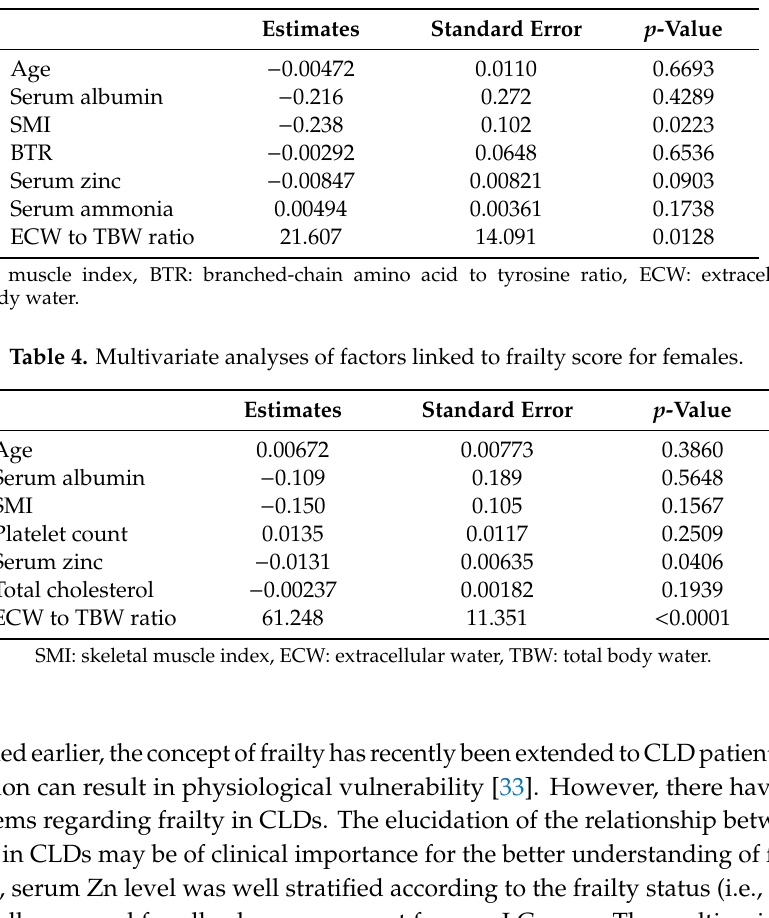
Table 3. Multivariate analyses of factors linked to frailty score for males.